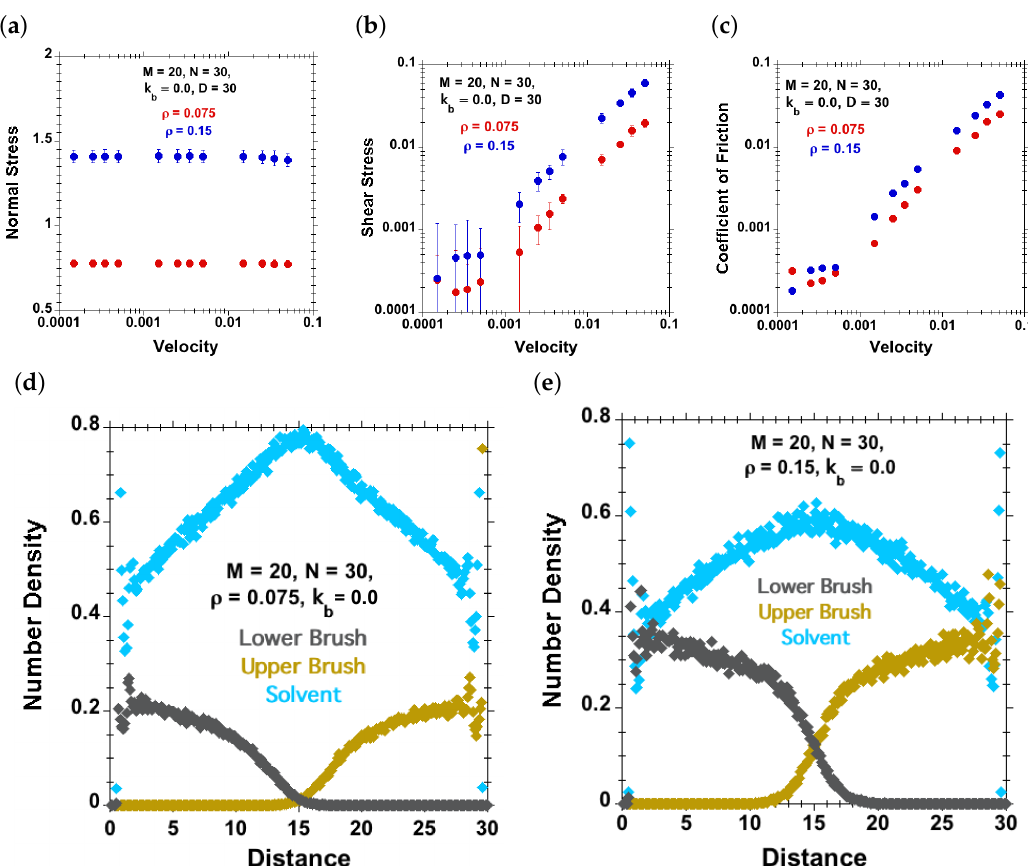
Figure 9. Effect of grafting density (red dots for ρ = 0.075 and blue dots for ρ = 0.15) for M = 20, N = 30, k b = 0, D = 30 and good-solvent quality. ( a ) Normal stress against velocity; ( b ) shear stress against velocity; ( c ) coefficient of friction against velocity (Approach B); ( d – e ) density profiles of solvent (cyan dots), lower polymer-chains (grey dots) and upper polymer-chains (brown dots) for ( d ) ρ = 0.075 and ( e ) ρ =